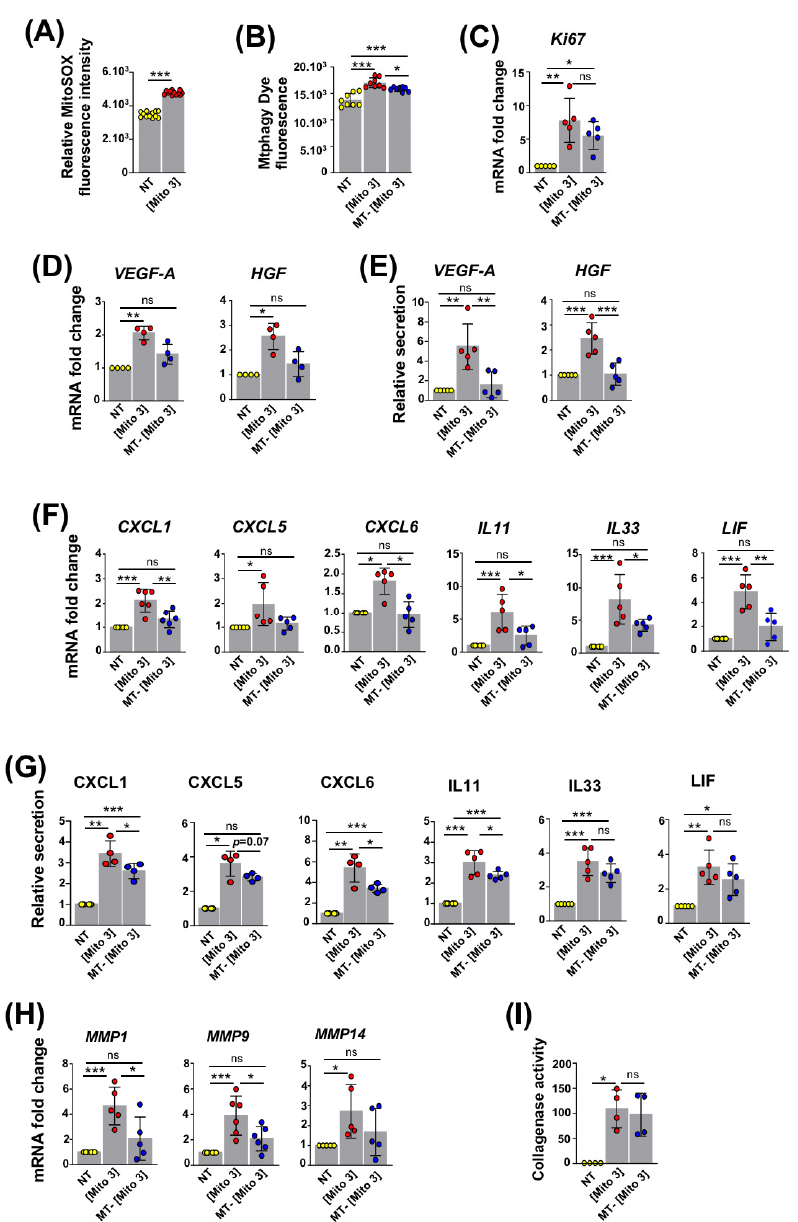
Figure 4. ROS from cardiac mitochondria trigger the mitophagy-dependent activation of MSCs. ( A ) MitoSOX fluorescence in MSCs following exposure to cardiac mitochondria (the Mito 3 concentration) ( n = 12). ( B – I ) MSCs were exposed to cardiac mitochondria (the Mito 3 concentration) previously treated with mitoTEMPO (MT) or not and compared with non-treated MSCs (NT). ( B ) Mtphagy fluorescence ( n = 8). ( C ) Relative mRNA expression ( n = 5). ( D ) Relative mRNA ( n = 4) and ( E ) protein secretion ( n = 5) levels of VEGF-A and HGF. ( F ) Relative mRNA ( n ≥ 5) and ( G ) protein secretion ( n = 4) levels of CXCL1, CXCL5, CXCL6, IL11, IL33 and LIF. ( H ) Relative mRNA expression of MMP1 , MMP9 and MMP14 ( n ≥ 5). ( I ) Relative collagenase activity ( n = 4). Unpaired Student’s t -test in ( A ). One-way ANOVA with Tukey’s multiple comparisons test in ( B , C , E , F , H ). One-way ANOVA with Dunn’s multiple comparisons test in ( D , G , I ). * p < 0.05, ** p < 0.01, *** p < 0.001. Each dot represents an independent experiment. Bar graphs represent mean values ± SD.